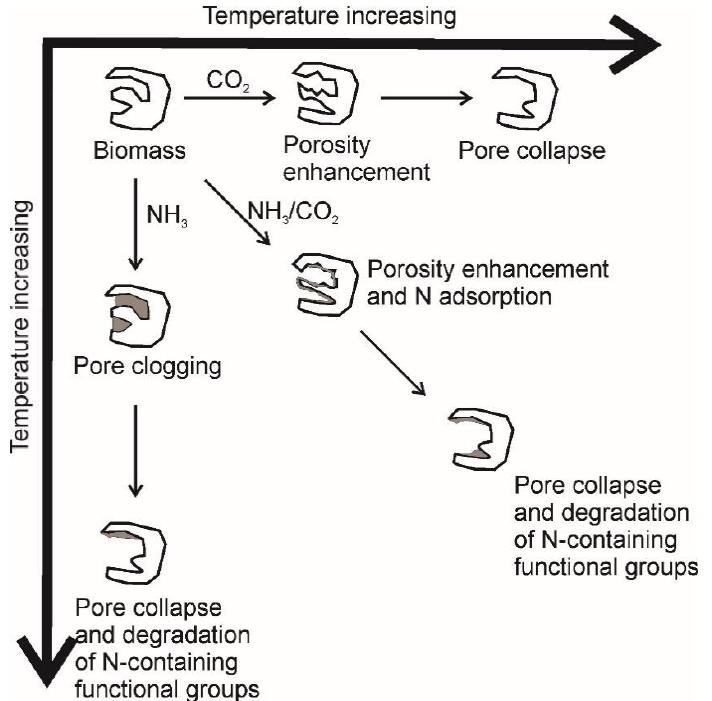
Figure 9. Scheme of pore formation in CO 2 , NH 3 , and CO 2 /NH 3 atmospheres. The grey color indicates the formation of a “glue”-like layer made by N-containing groups. The scheme has been elaborated from References [125,126].